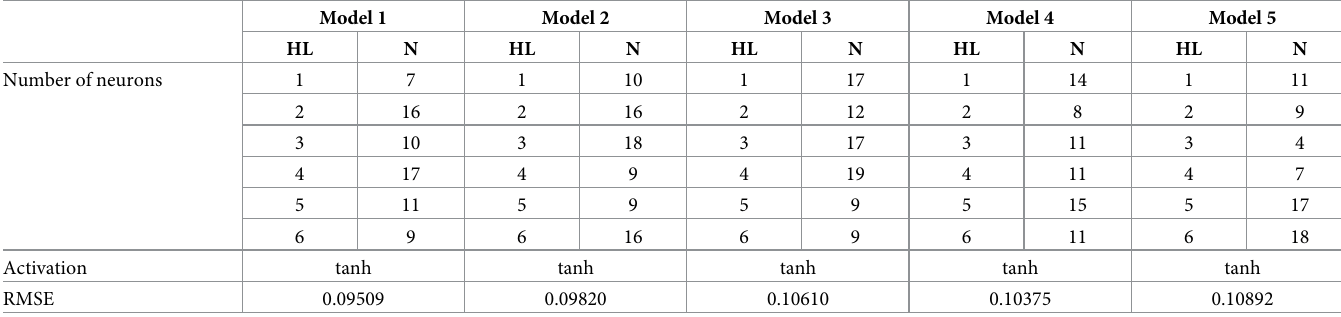
Activation RMSE Note. HL = Hidden Layer; N = Number of neurons.